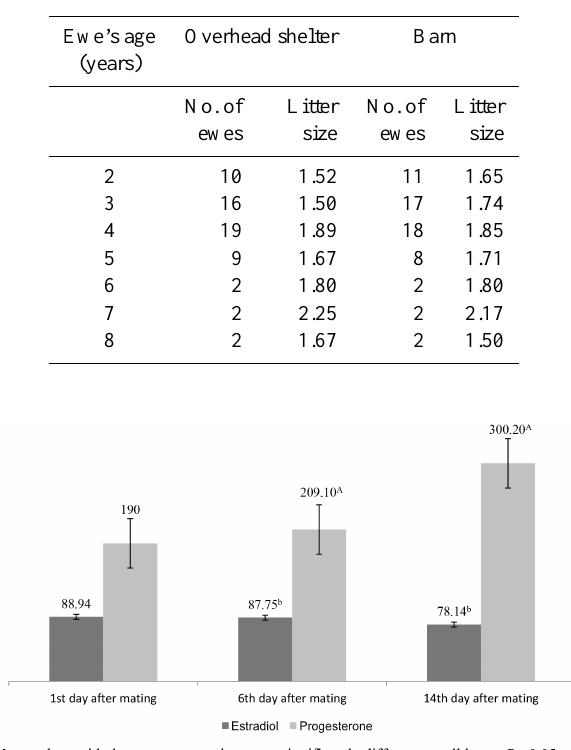
Figure 4. The concentration of progesterone and estradiol (pgmL − 1 ) in peripheral blood of